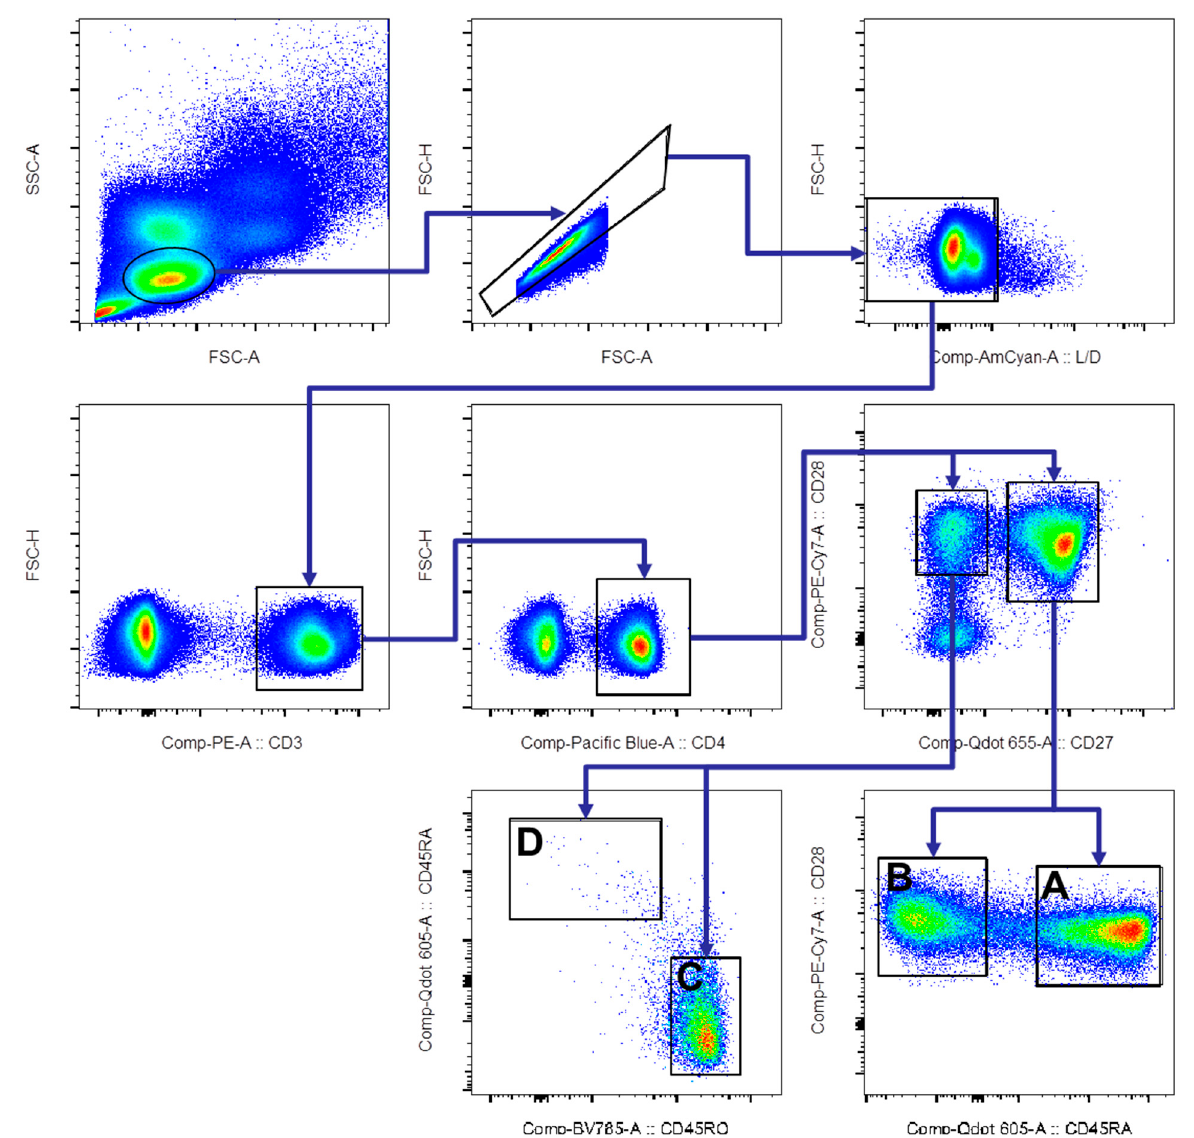
Figure 1. Gating and sorting strategy for CD4+ T cells gated for FSC/SSC, singlets, live cells, CD3+ and CD4+. Subsets gated as (A) naïve: CD28+ CD27+ and CD45RA+; (B) central memory: CD28+ CD27+ CD45RA-; (C) e ff ector memory: CD28+ CD27- CD45RO+ CD45RA-; and (D) TEMRA: CD28+ CD27- CD45RO- CD45RA+ ( n = 1; representative donor). CD27- CD45RO- CD45RA+ ( n = 1; representative